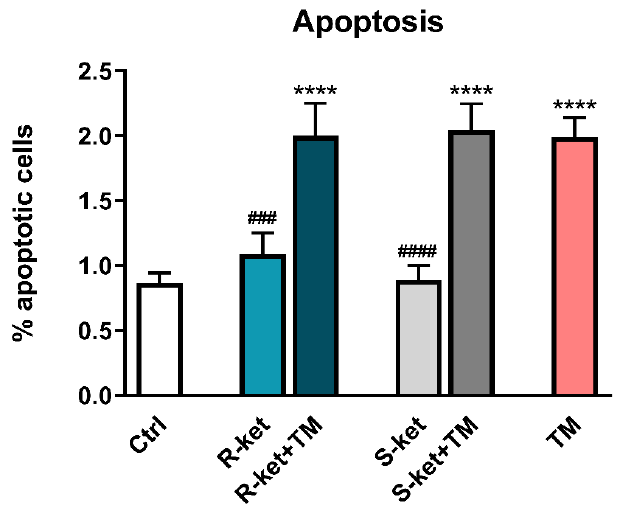
Figure 5. Effects of tunicamycin alone (TM), R-ketamine alone (R-ket), S-ketamine alone (S-ket) or R-ketamine and S-ketamine in tunicamycin-treated astrocytes (R-ket + TM or S-ket + TM) on induction of apoptosis in astrocytes. Data are presented as the mean ± SEM and expressed as a percentage of untreated control cells. Statistical significance vs. control cells is indicated when appropriate; **** p < 0.0001 vs. untreated control; ### p < 0.001 and #### p < 0.0001 vs. tunicamycin-treated cell.